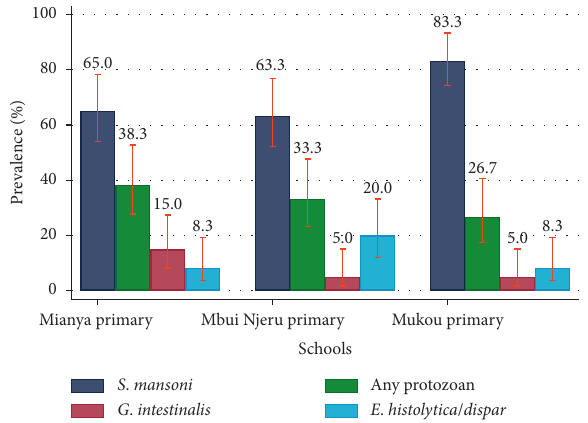
Figure 1: Prevalence of intestinal parasitic infections in school children per